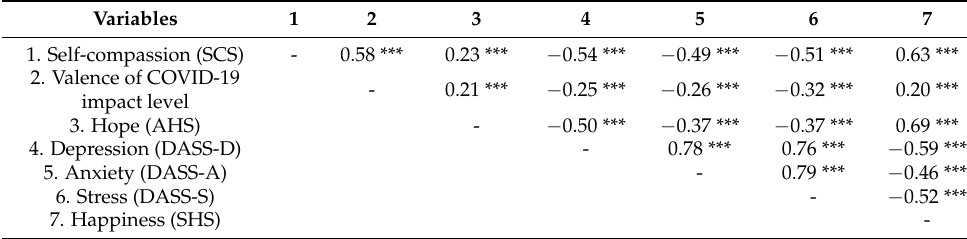
Table 3. Correlations between study variables.